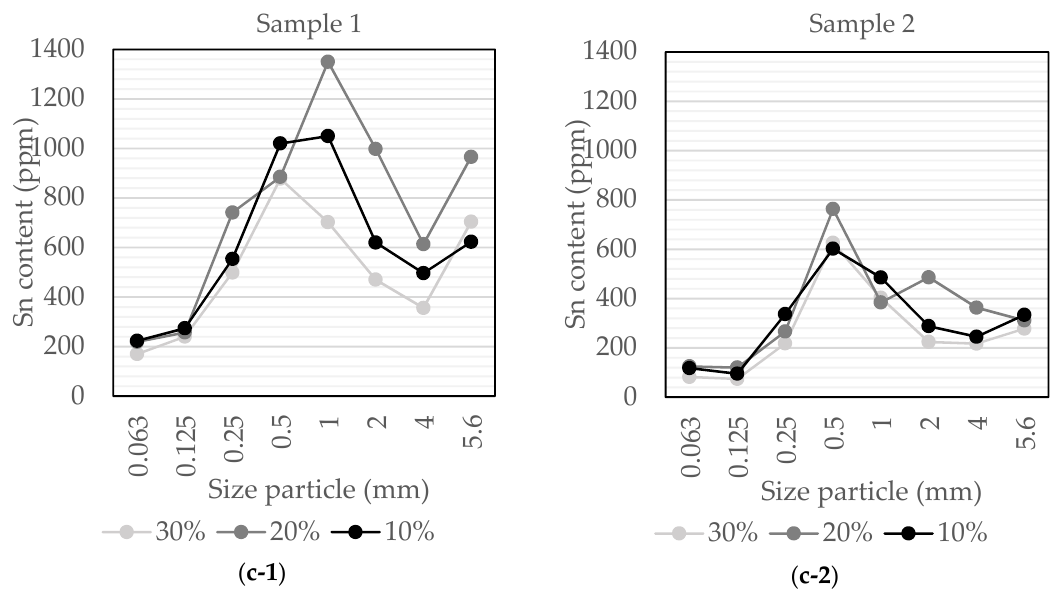
Figure 6. Representative trace elements content of the Penouta ore after compression breakage for ( a ) tantalum, ( b ) niobium, and ( c ) tin potassium oxide for sample 1 and sample 2.